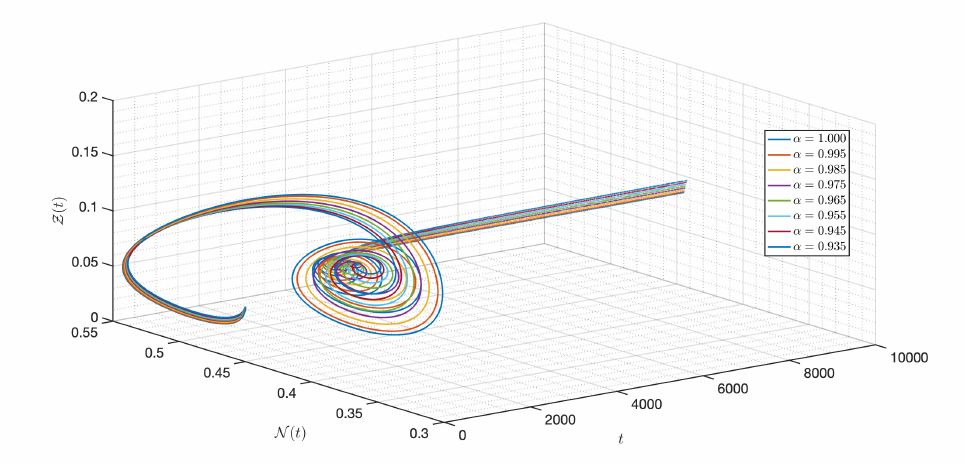
Figure 39. Dynamic of the model (3) for different parameters in Case IV